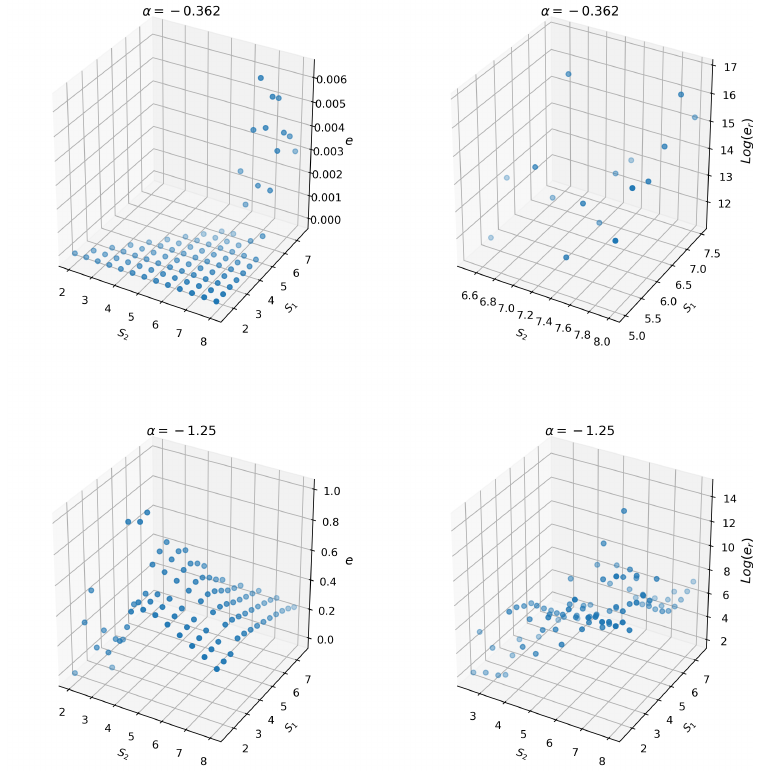
Figure 14. The maximum efficiency e , Equation (11) and er , of Equation (12), of the Otto cycle that works among two adiabatic curves, s 1 < s 2, is displayed in this figure for the asymmetry parameter α = − 0.362 and α = −